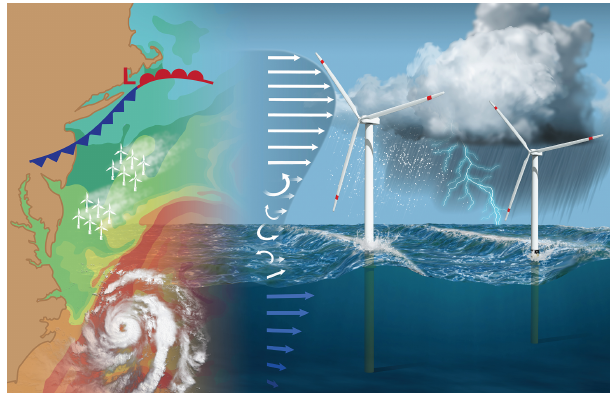
Figure 1. Illustration of phenomena affecting offshore wind plants at varying scales on the US East Coast. Spatial scales range from tropical hurricanes and mid-latitude storm systems such as nor’easters through composite wind plant wakes and low-level jets to breaking waves and small turbulent eddies. The spatial tem- perature variations arising from the Gulf Stream and the land–sea boundary drive circulations such as sea breezes and modulate ther- modynamic stratification. Cloud microphysical processes generate liquid and solid precipitation that can erode leading edges of wind turbine